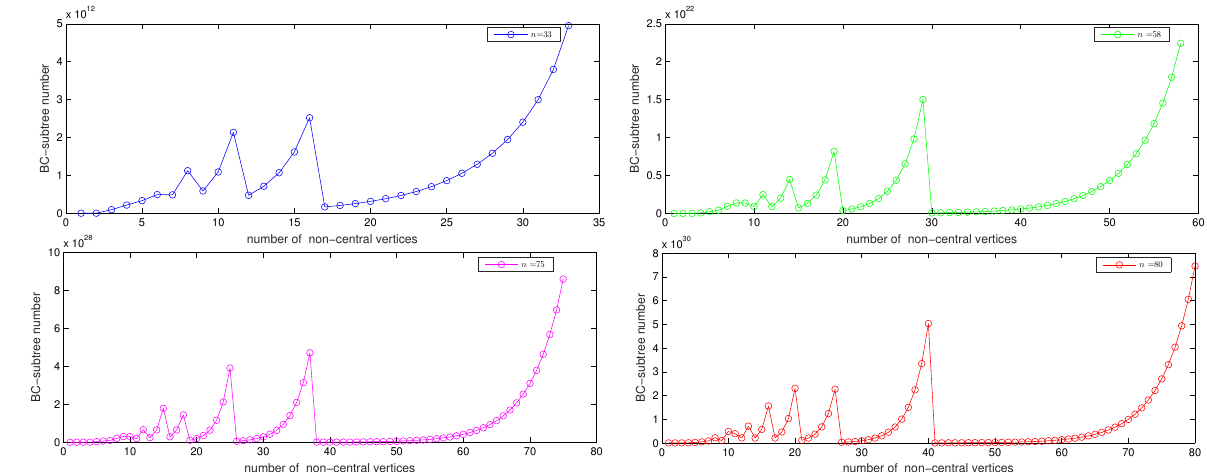
( a ) BC-subtree numbers of F r with n = 33,58,75,80, r from 1 to n , respectively in Cartesian coordinate. n + 1